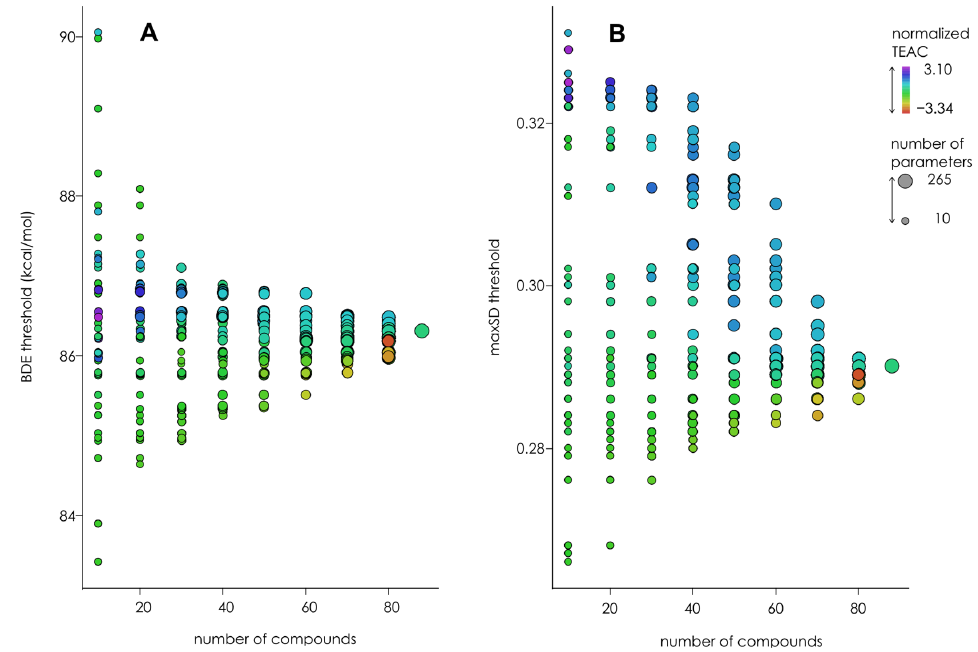
Figure 3. Convergence of BDE ( A ) and maxSD ( B ) thresholds calculated by “sliding” approach using ABTS ● + experimental data. The electronic parameters were obtained in AM1 simulation without COSMO corrections. Color codes represent the TEAC sum for each subgroup, normalized over the subgroups with the same number of compounds. The size of the points represents the number of parameters falling into any given subgroup.